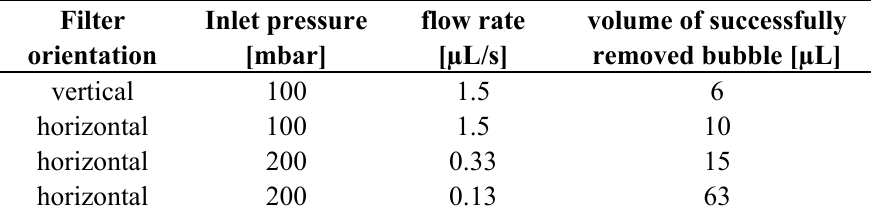
Table 1. Characterization of a tube micro-debubbler at various pressures and flow